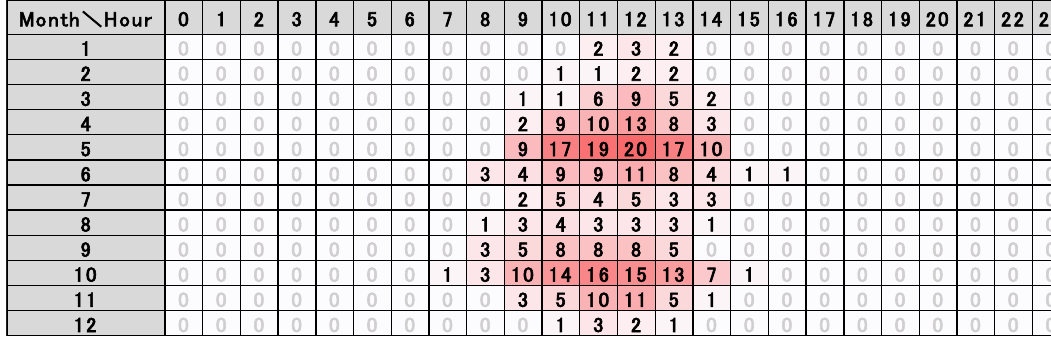
Figure 1. The number of DR occurrences by month and time.